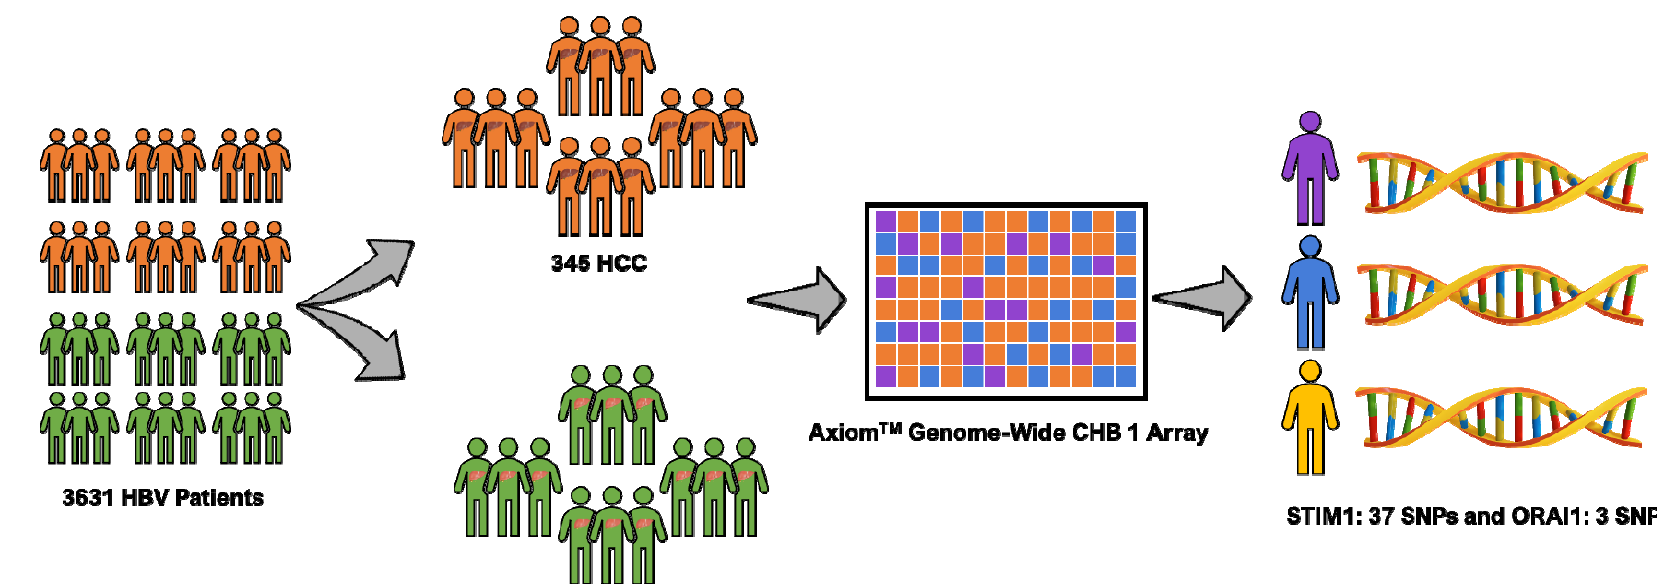
Figure 1. Data from 3631 hepatitis B virus (HBV) patients including 3286 subjects without hepatocellular carcinoma (HCC) and 345 subjects with HCC were analyzed. Axiom-chronic hepatitis B -(CHB) genome-wide array was used for genotyping. A total of 40 single nucleotide polymorphism (SNPs) were assessed (37 STIM1 and three ORAI1 ) through this method.